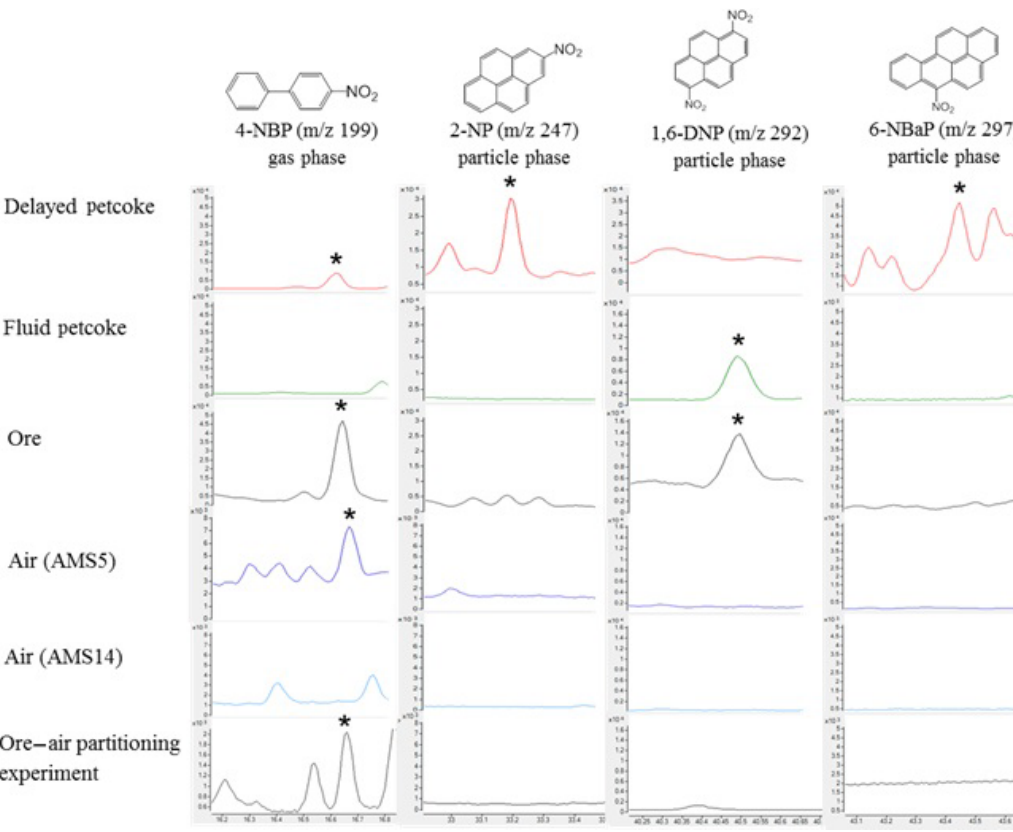
Figure 5. GC-MS extracted ion chromatograms of 4-nitrobiphenyl (4-NBP), 2-nitropyrene (2-NP), 1,6-dinitropyrene (1,6-NP), and 6- nitrobenzo(a)pyrene (6-NBaP) in a selection of samples including delayed petcoke, fluid petcoke, oil sands ore, passive dry deposition sample at AMS5, passive dry deposition sample at AMS14, and air sample collected from the ore–air partitioning study. The phase distribution of each marker is also indicated as gas phase or particle